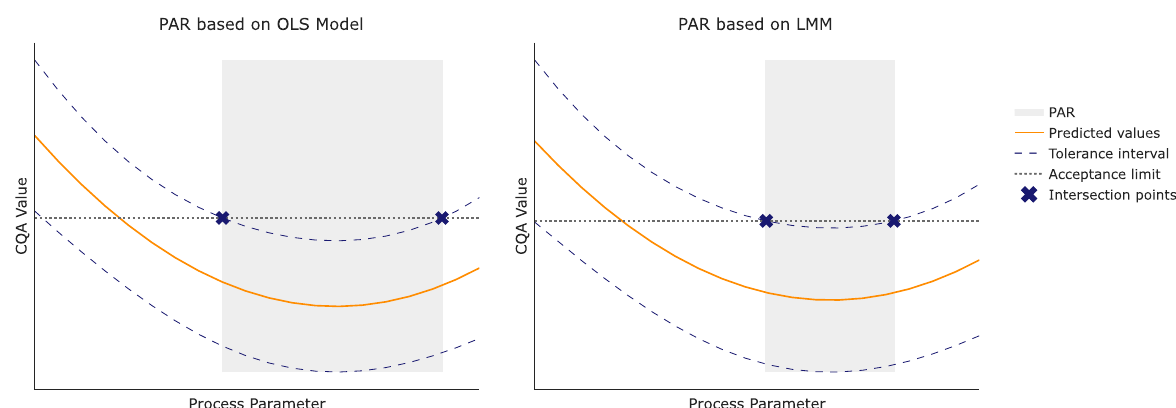
Fig. 6 PAR for a randomly picked parameter calculated from case study data. Due to the contribution of the random effect, the interval based on LMM variance components (right) is wider than its OLS counterpart (left). This results in smaller PAR (gray area) and a more conservative control strategy. In this example from the case study, the OLS PAR is 72% larger than the more conservative LMM